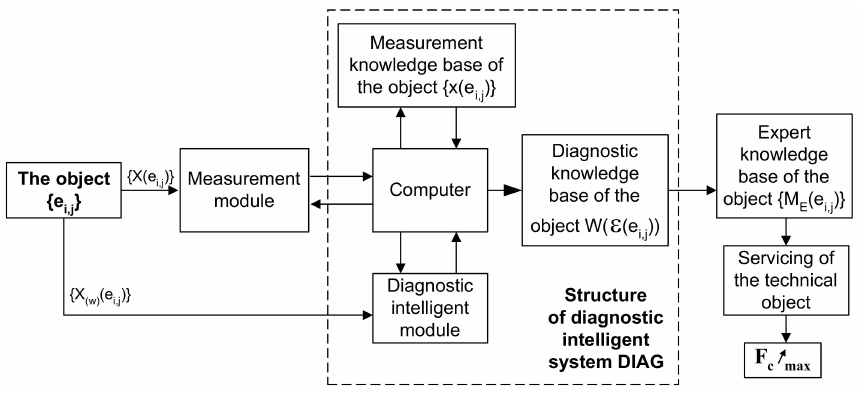
Figure 1. Diagram of an intelligent effective diagnosing system of a complex technical